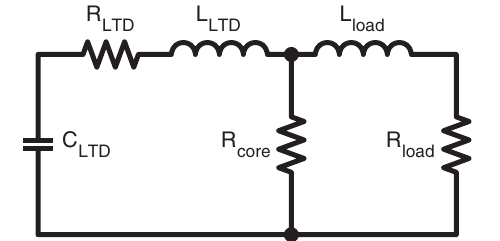
FIG. 7. Simplified equivalent circuit of the LTD with core